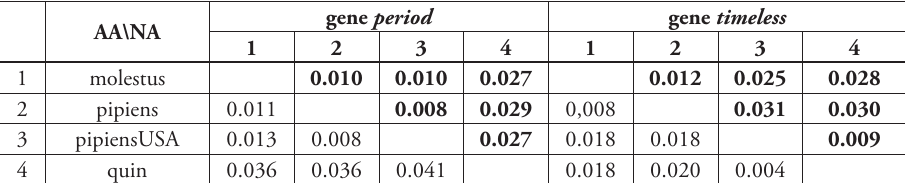
In upper right section in bold: the number of nucleotide base substitutions (NA) per site from averaging over all sequence pairs between groups is shown. All results are based on the pairwise analysis of 20 sequences. There were a total of 2300 positions of per gene and 1560 positions of tim gene in the final dataset. In lower left section: the number of amino acid substitutions (AA) per site from averaging over all sequence pairs between groups are shown. The analysis involved 20 amino acid sequences. A total of 766 positions of the gene per and 520 positions of the gene tim were analysed as the final dataset.